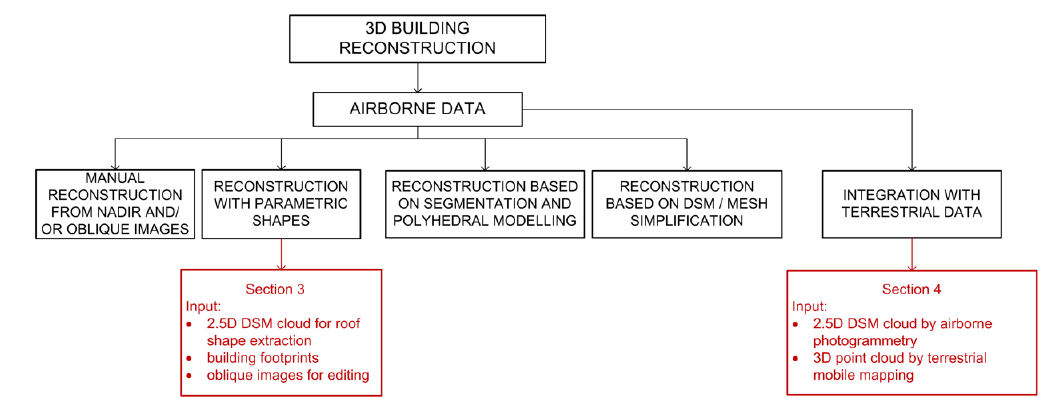
Figure 1. General methods for 3D building reconstruction from airborne data and specific approaches investigated in the paper (red text,